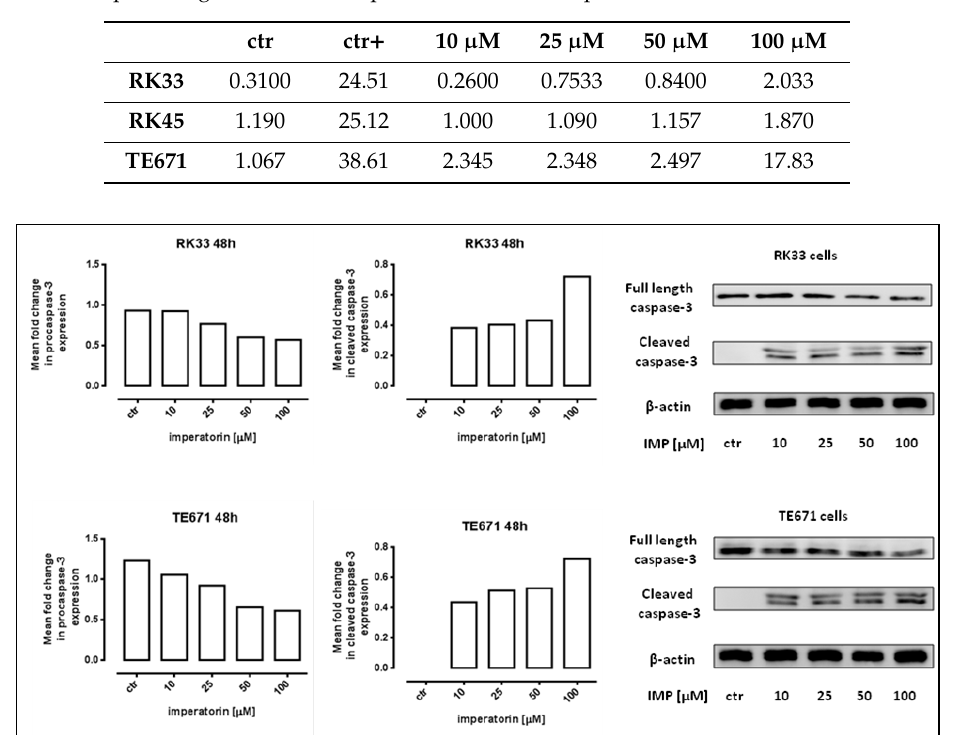
Figure 4. Western blotting analysis of the full length and cleaved caspase-3 activities following 48 h incubation of RK33 and TE671 cells with either culture medium alone (control) or imperatorin (IMP) (10–100 µM). β-actin was used as a gel loading control. The right panel shows representative blots; the left panel shows a densitometry analysis of the bands.